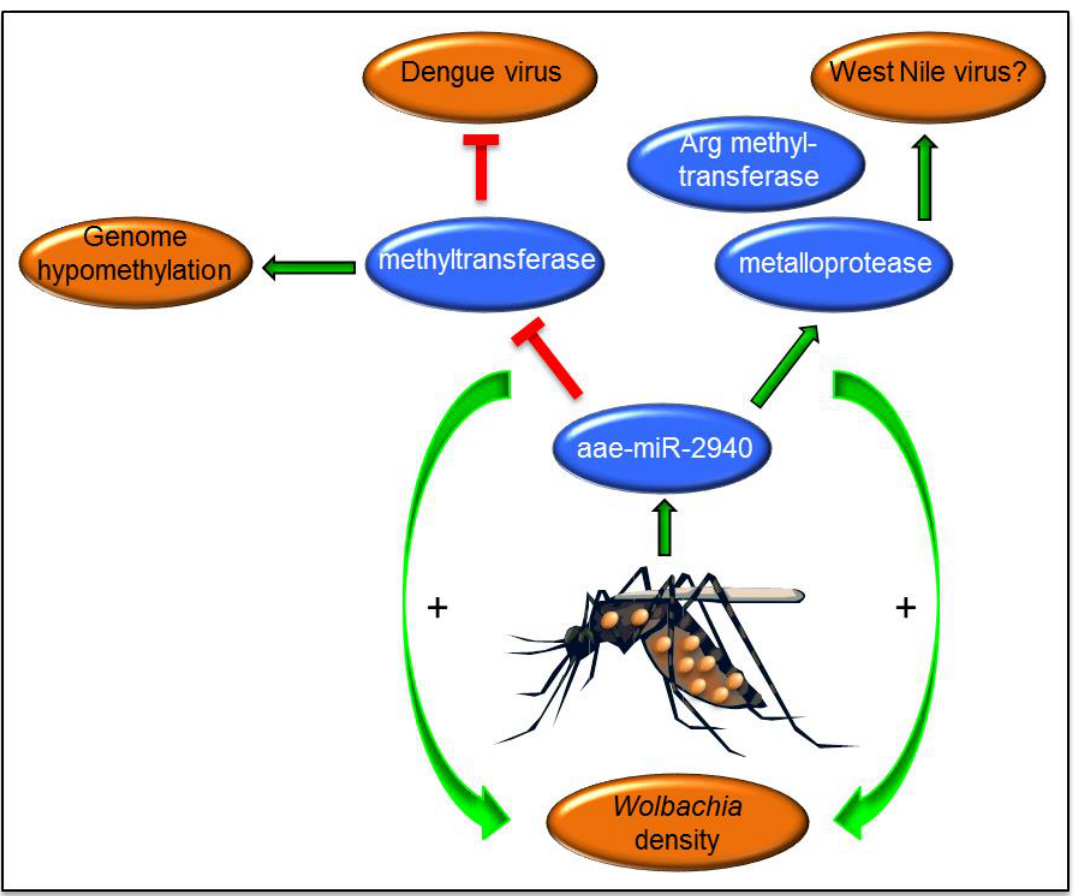
Figure 2. aae-miR-2940-5p is a mosquito-specific miRNA that is highly induced in Wolbachia -infected mosquitoes. Three targets of this miRNA validated so far are metalloprotease ftsh, DNA methyltransferase Dnmt2 and Arginine methyltransferase 3 that are important in Wolbachia maintenance and/or affect arbovirus replication. Green arrows indicate induction/enhancement, whereas red colour indicates